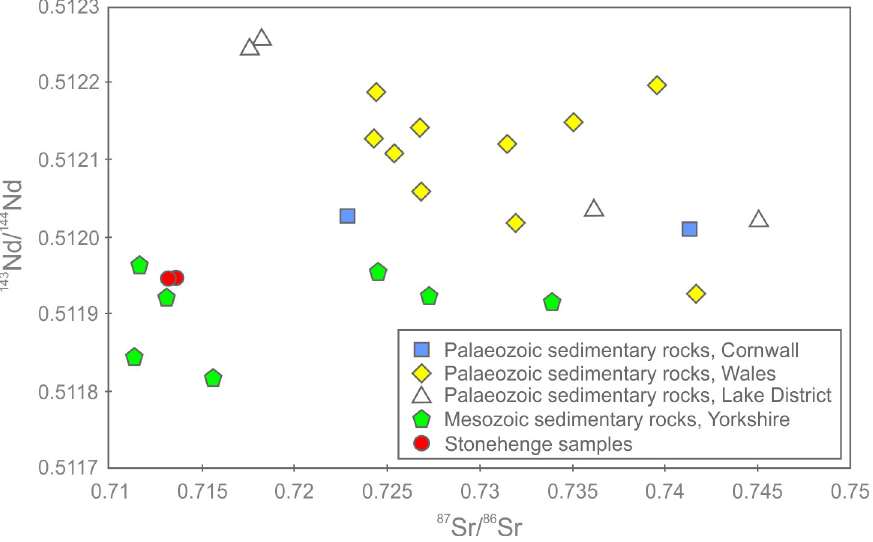
Fig 23. Sr and Nd isotope data for the whole-rock samples from the Phillips’ Core at Stonehenge plotted alongside equivalent published data for UK lithologies [data from 63].